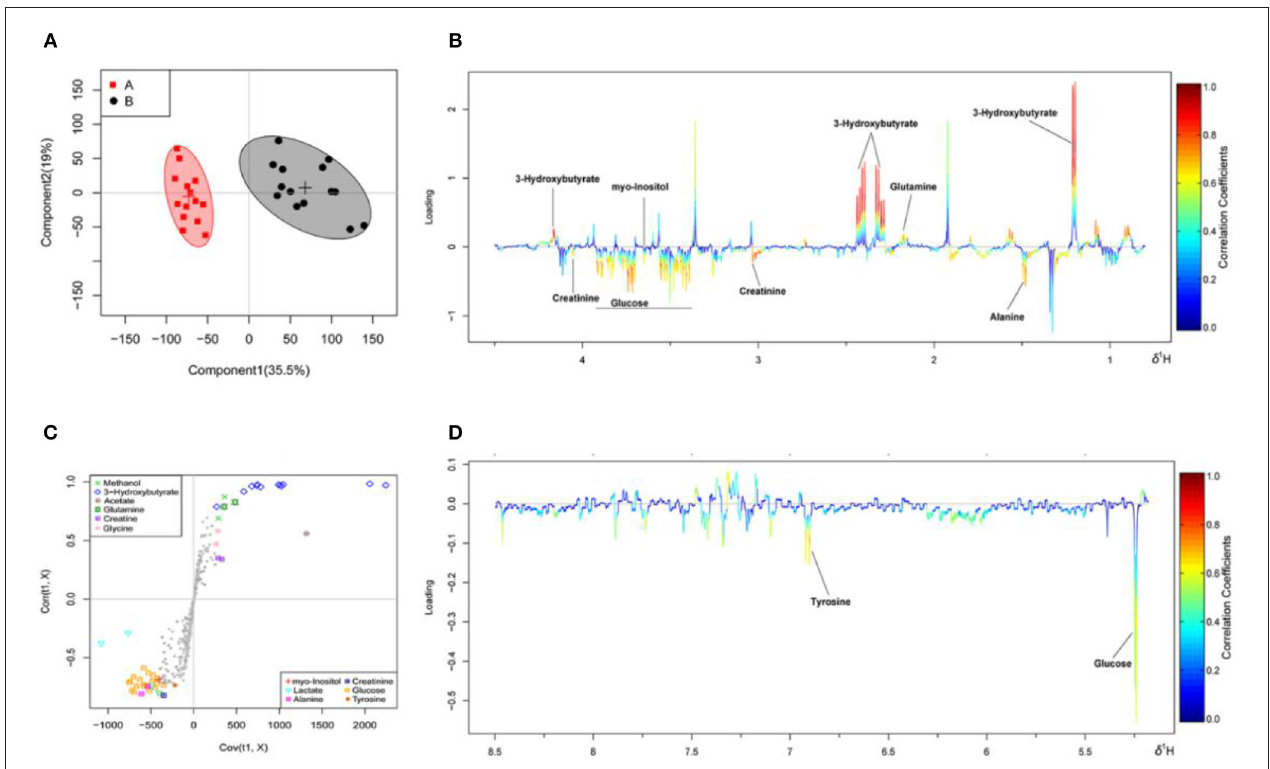
FIGURE 3 | Orthogonal signal correction partial least squares discriminant analysis (OSC-PLS-DA) of serum 1 H-NMR data from groups A and B. (A) Score plot in which one point represents one sample and one ellipse represents a confidence interval of 95. A: estrus group ( ); B: inactive ovaries group (•). (B,D) Corresponding loadings plot (0.5–4.4 ppm, 5.175–8.5 ppm) where the significance is from highest in red to lowest in blue. Metabolites above the baseline are more abundant in group B, while under the baseline are more abundant in group A. (C) S-plot in which different metabolites are distinguished by different colors and shapes. The different metabolites are in the upper right or lower left, and the metabolite is more significantly different if it is farther away from the